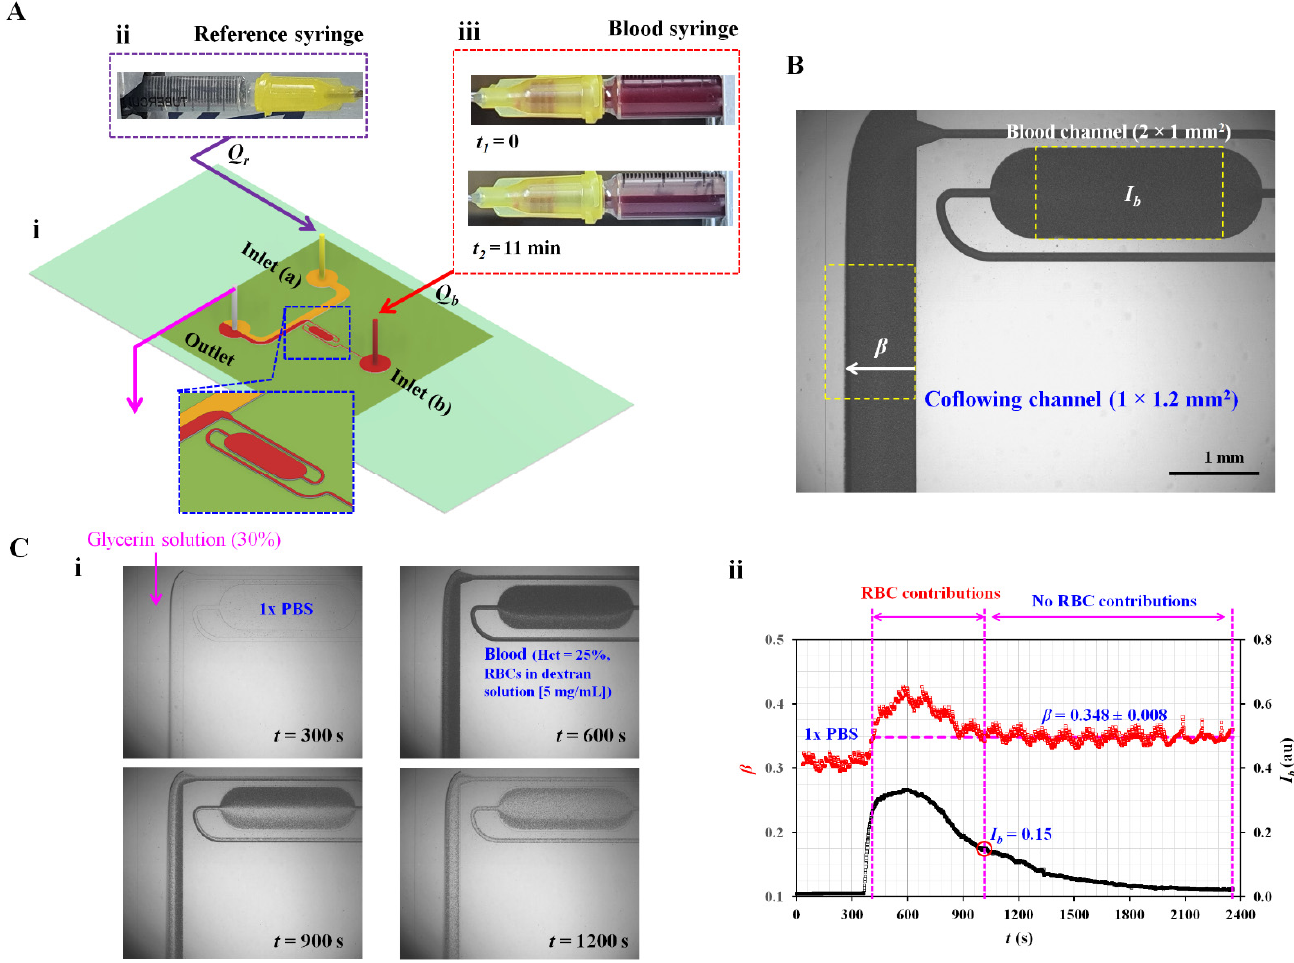
Figure 1. Proposed method for quantifying RBC sedimentation in blood syringes. ( A ) Schematic diagram of proposed method, which consisted of a microfluidic device and two syringe pumps. ( A - i ) Microfluidic device with blood channel, coflowing channel, two inlets (a and b), and one outlet. Each syringe pump was set to Q r (reference fluid) and Q b (blood) constantly over time. ( A - ii ) Snapshot for reference syringe. ( A - iii ) Two snapshots of the blood syringe captured at two specific times (i.e., t 1 = 0 and t 2 = 11 min). ( B ) Two parameters ( I b and β ) obtained by analyzing blood flow. Image intensity ( I b ) was quantified by analyzing blood flow selected within the blood channel with ROI (2 × 1 mm 2 ). Blood-filled width ( β ) in the coflowing channel with ROI (1 × 1.2 mm 2 ) was obtained by analyzing the interface. ( C ) Contributions of RBCs to blood flow in terms of the two parameters ( I b and β ). ( C - i ) Microscopic images showing blood flow in the blood channel and interface in the coflowing channel with an elapse of time ( t ) ( t = 300, 600, 900, and 1200 s). ( C - ii ) Temporal variations in β and I b . When image intensity was less than 0.15 ( I b < 0.15), the β remained as β = 0.348 ± 0.008.